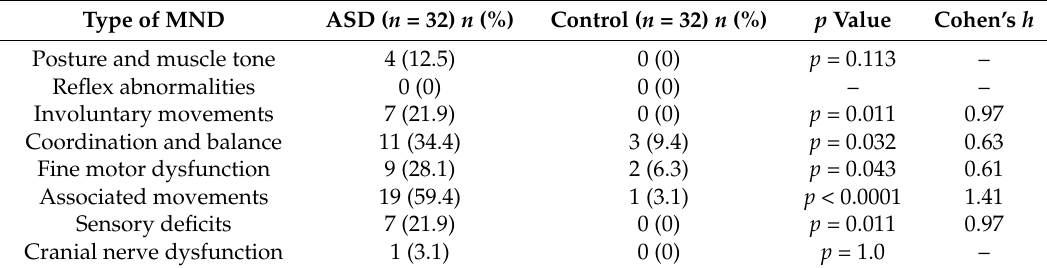
Table 2. Prevalence of the specific types of MND in ASD and control